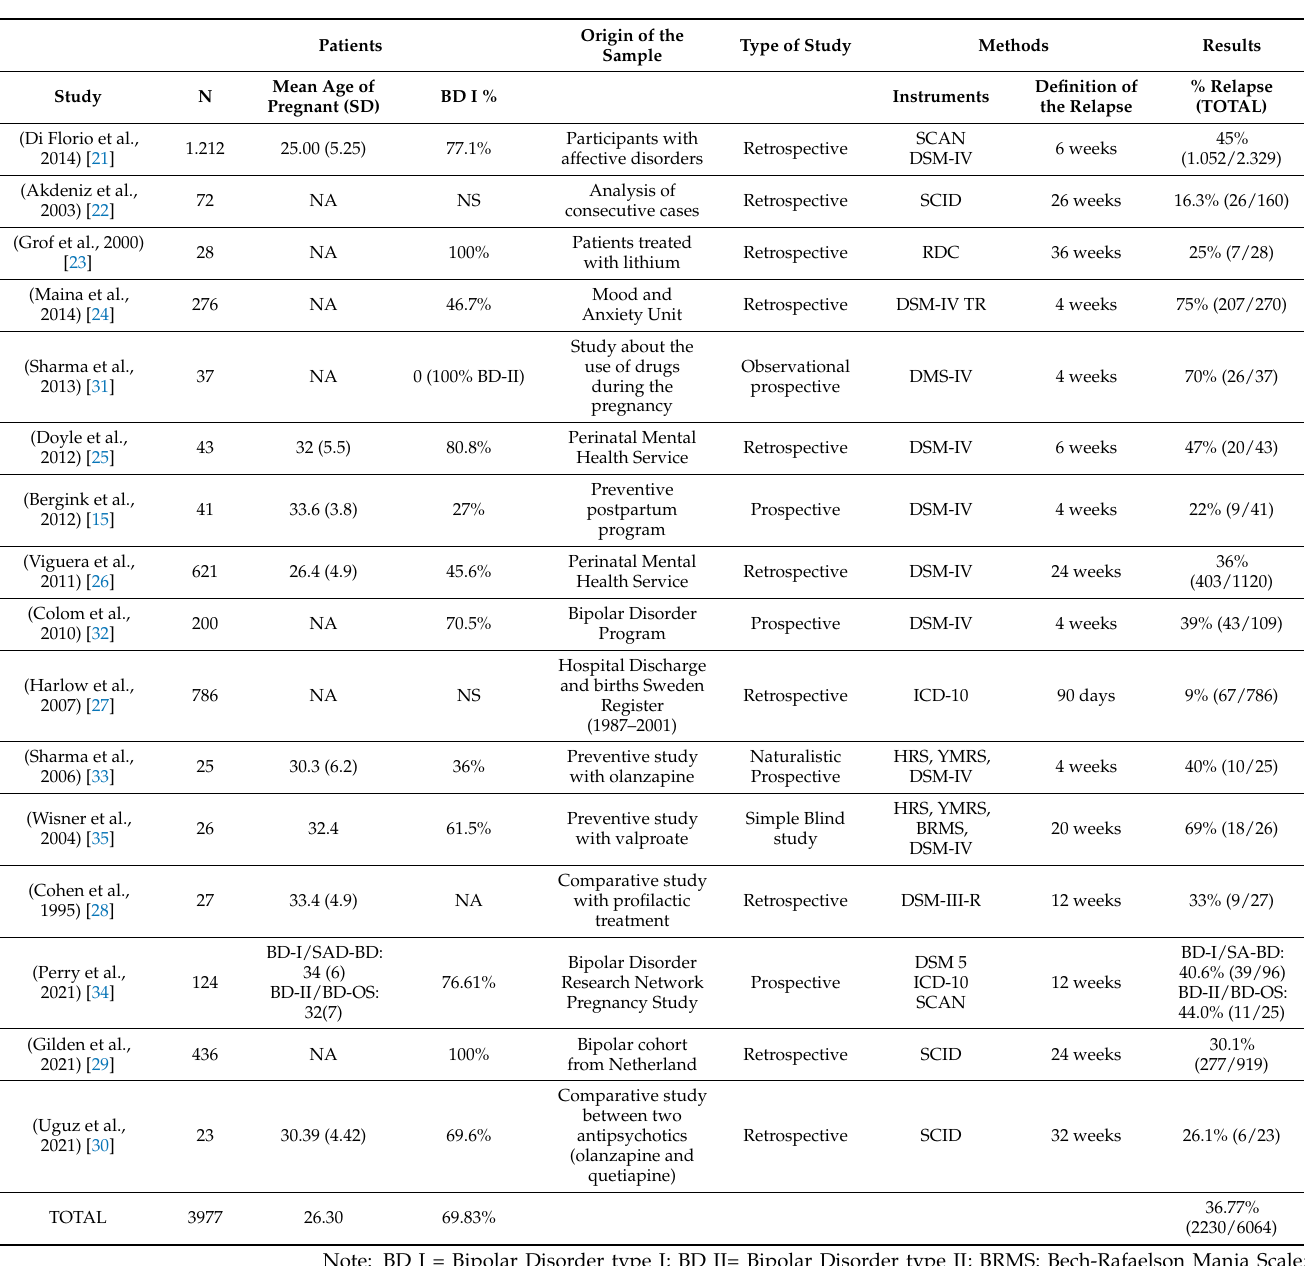
Table 1. Results of studies estimating the prevalence of postpartum relapse in patients with bipolar